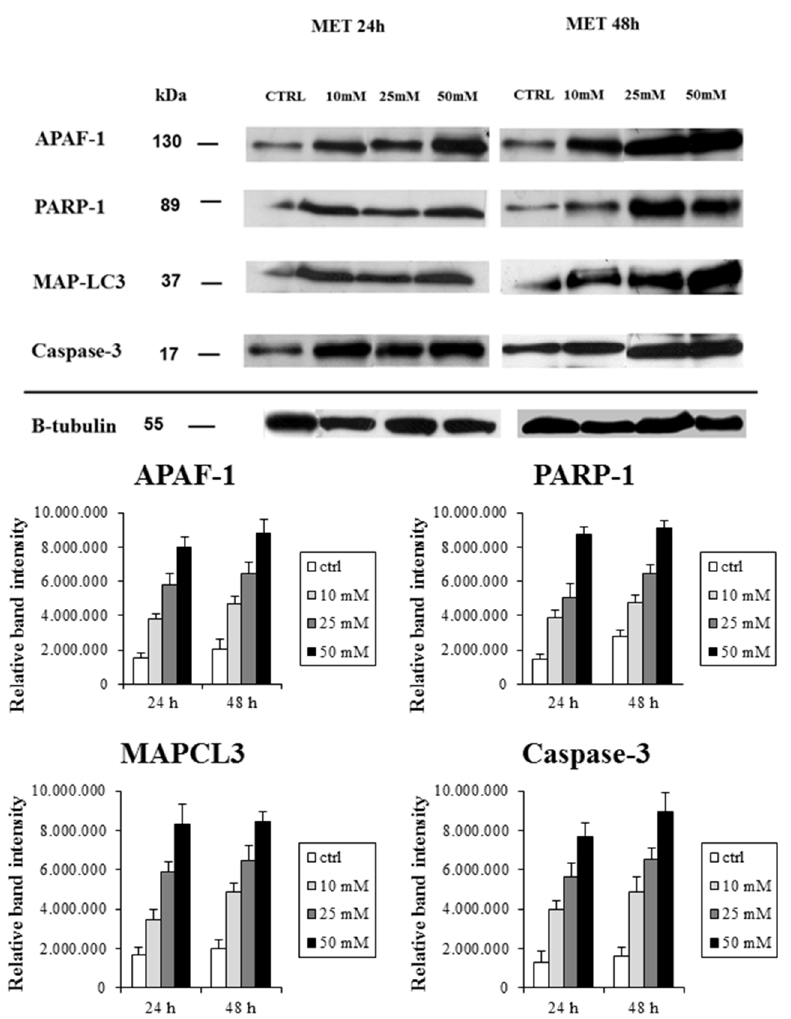
Figure 5. Western blot analysis of HT29 cells treated with graded concentrations of metformin, 10 mM/25 mM/50 mM for 24 h and 48 h; and of untreated cells (CTRL), using anti-APF-1, PARP-1, MAPLC3, and Caspase-3 antibodies. Mean densitometric data of APAF-1, PARP-1, MAPLC3, and Caspase-3 expressions were analyzed using NIH Image J software. p < 0.05 between all group